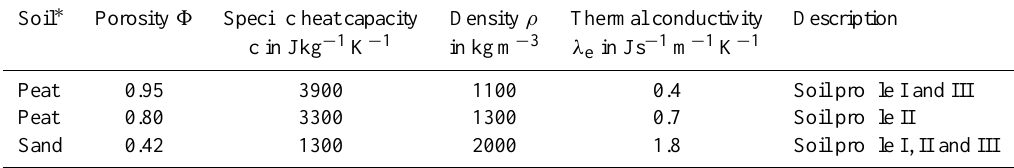
Table 1. Physical and thermal properties of the soil profiles defined for the field site in the Upper Biebrza